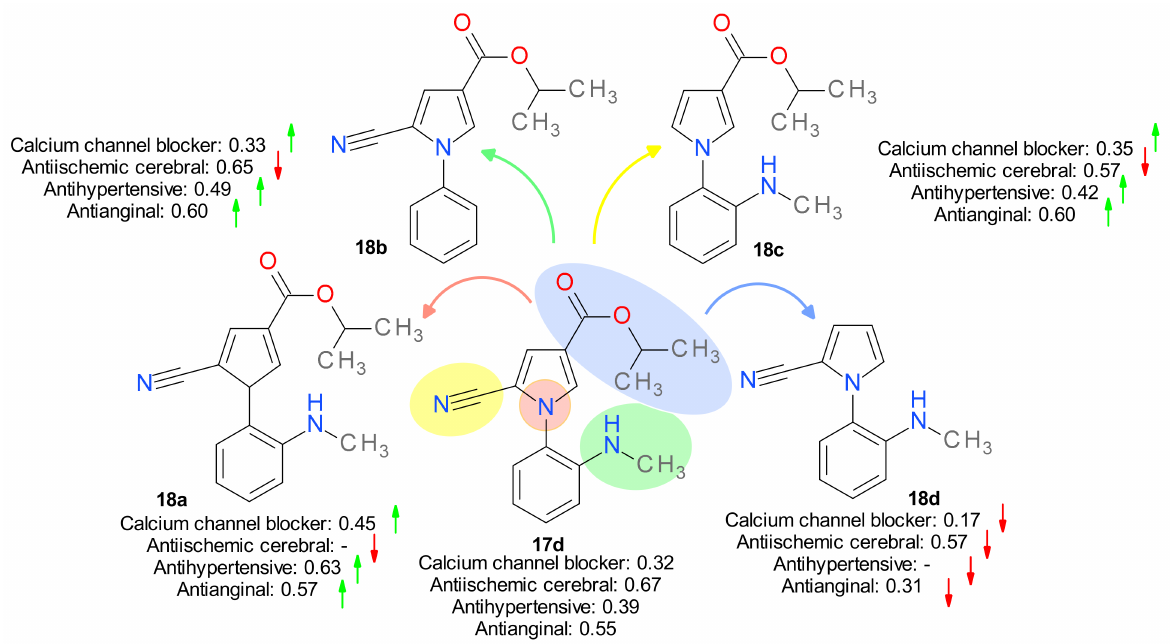
Figure 10. The PASS predicted Pa values after simple transformations applied to compound 17d . The arrows indicate the rapport of each Pa value with that corresponding to compound 17d